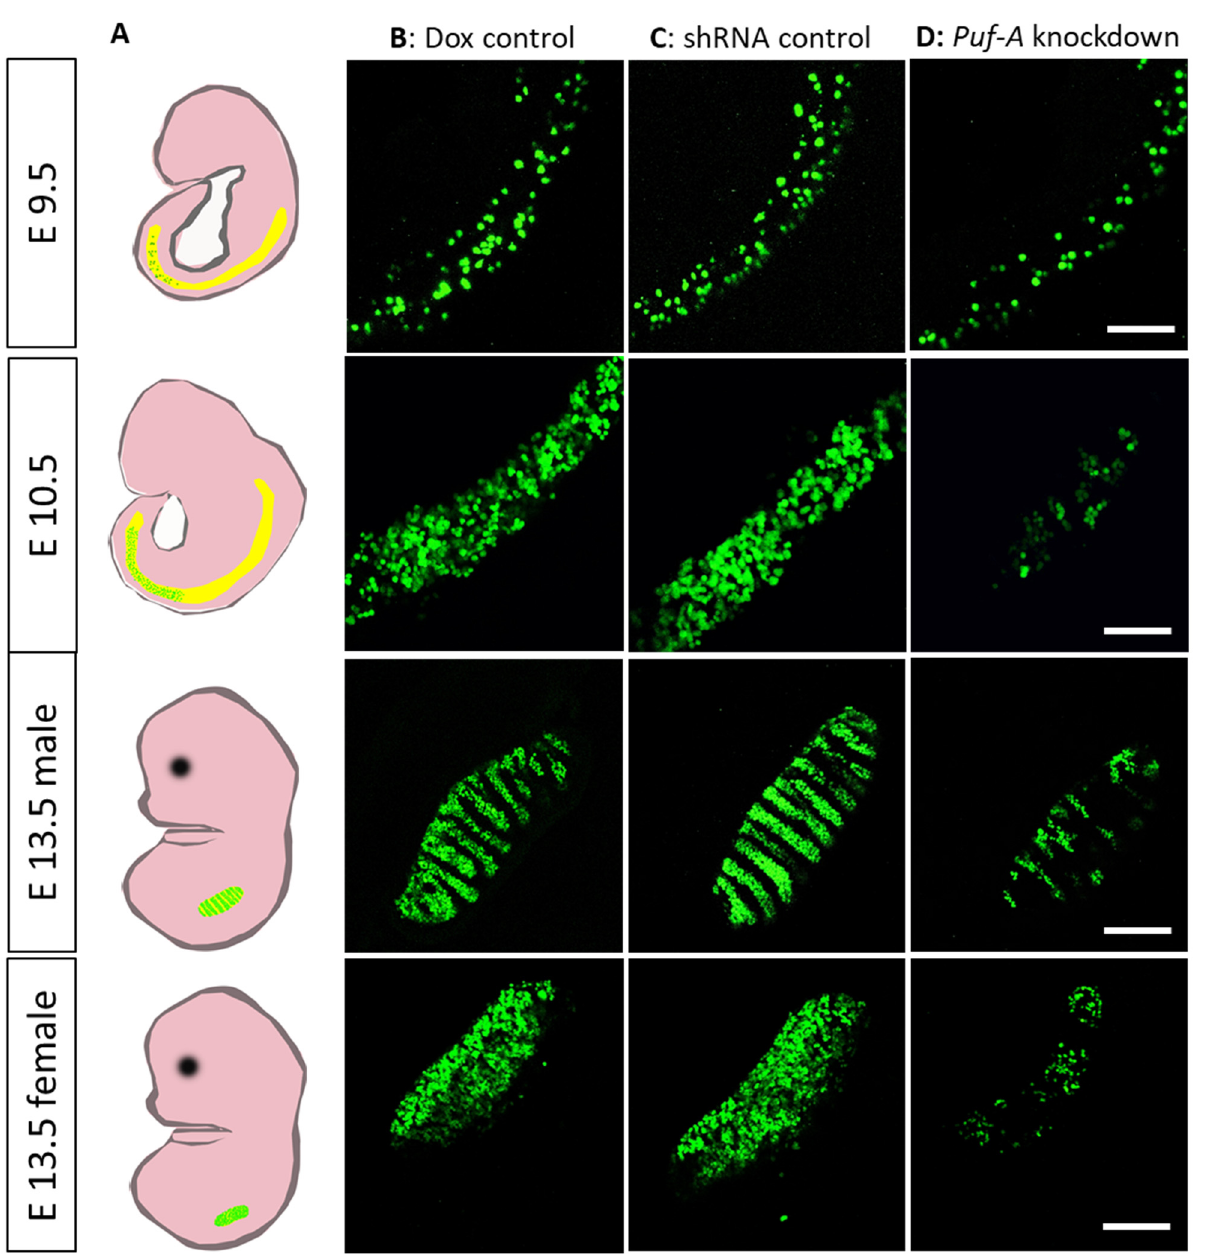
Figure 3. Puf-A is required for PGC growth during gonad development. ( A ) Schematic presentation for the location of PGCs in mouse embryos at E9.5, E10.5, and E13.5. PGCs were found in gut tube at E9.5; then they proliferated at E10.5. At E13.5, these PGCs migrated to lateral genital ridges and colonized in gonads. Green dots indicated PGCs. ( B , C ) The Oct4 -EGFP + PGCs from the embryos of Dox control ( B ) and shRNA control ( C ) mice showed plentiful cell growth in the hindgut tube of E9.5 to E10.5 embryos, and finally colonization of PGCs in genital ridges of male and female embryos at E13.5. ( D ) The Oct4 -EGFP + PGCs from the Puf-A knockdown embryos at E9.5 showed a slight decrease in cell number in the hindgut; in contrast, at E10.5 and E13.5, very few PGCs were observed. At least 12 embryos were used for each time points and with each genotype. Scale bars: 100 μ m.